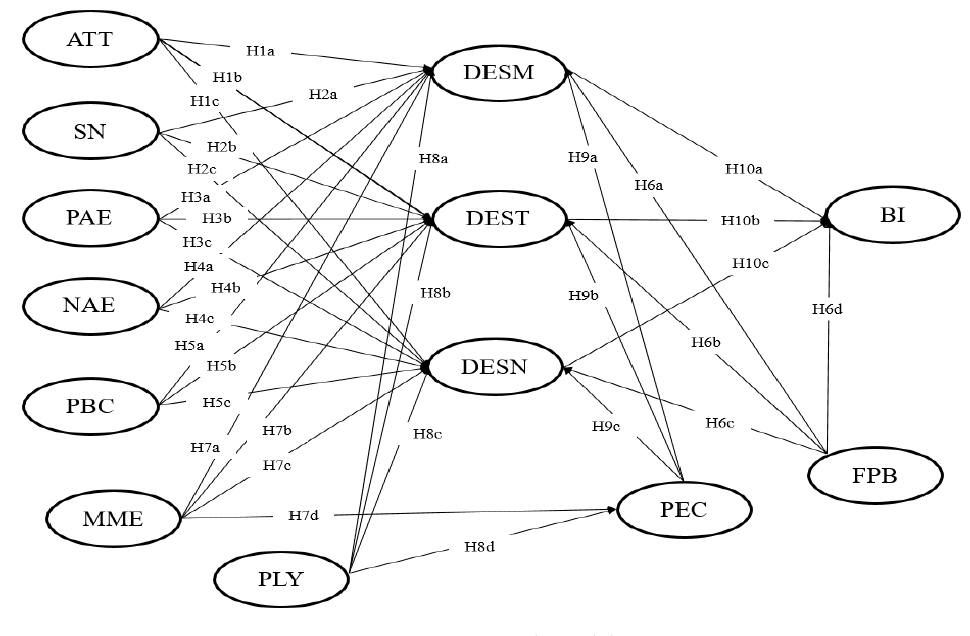
Figure 1. Research model.